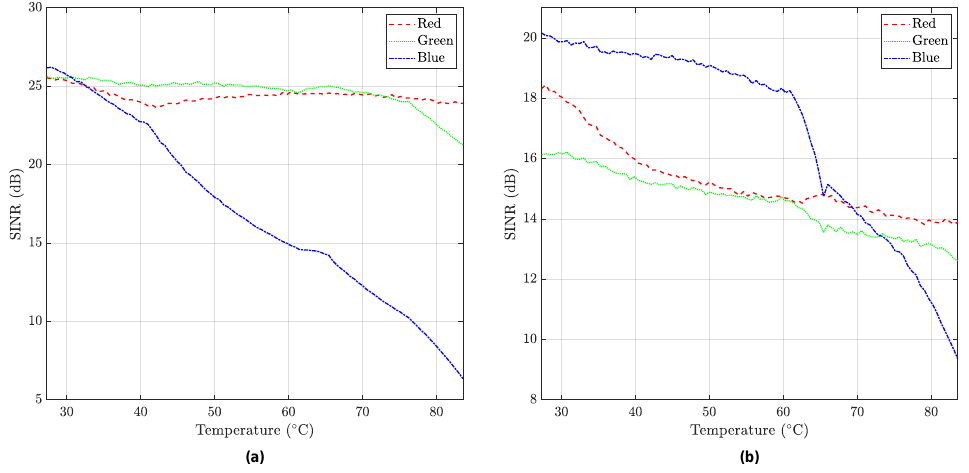
Figure 7. Signal-to-Interference-plus-Noise Ratio (SINR) at different temperatures, compensating the channel using the Channel State Information (CSI) corresponding to 27°C and with a high SNRvalue (30 dB). ( a ) Sony IMX249 and ( b ) Foveon X3. Dashed line, dotted line, and dash-dot line correspond to red, green, and blue, respectively.